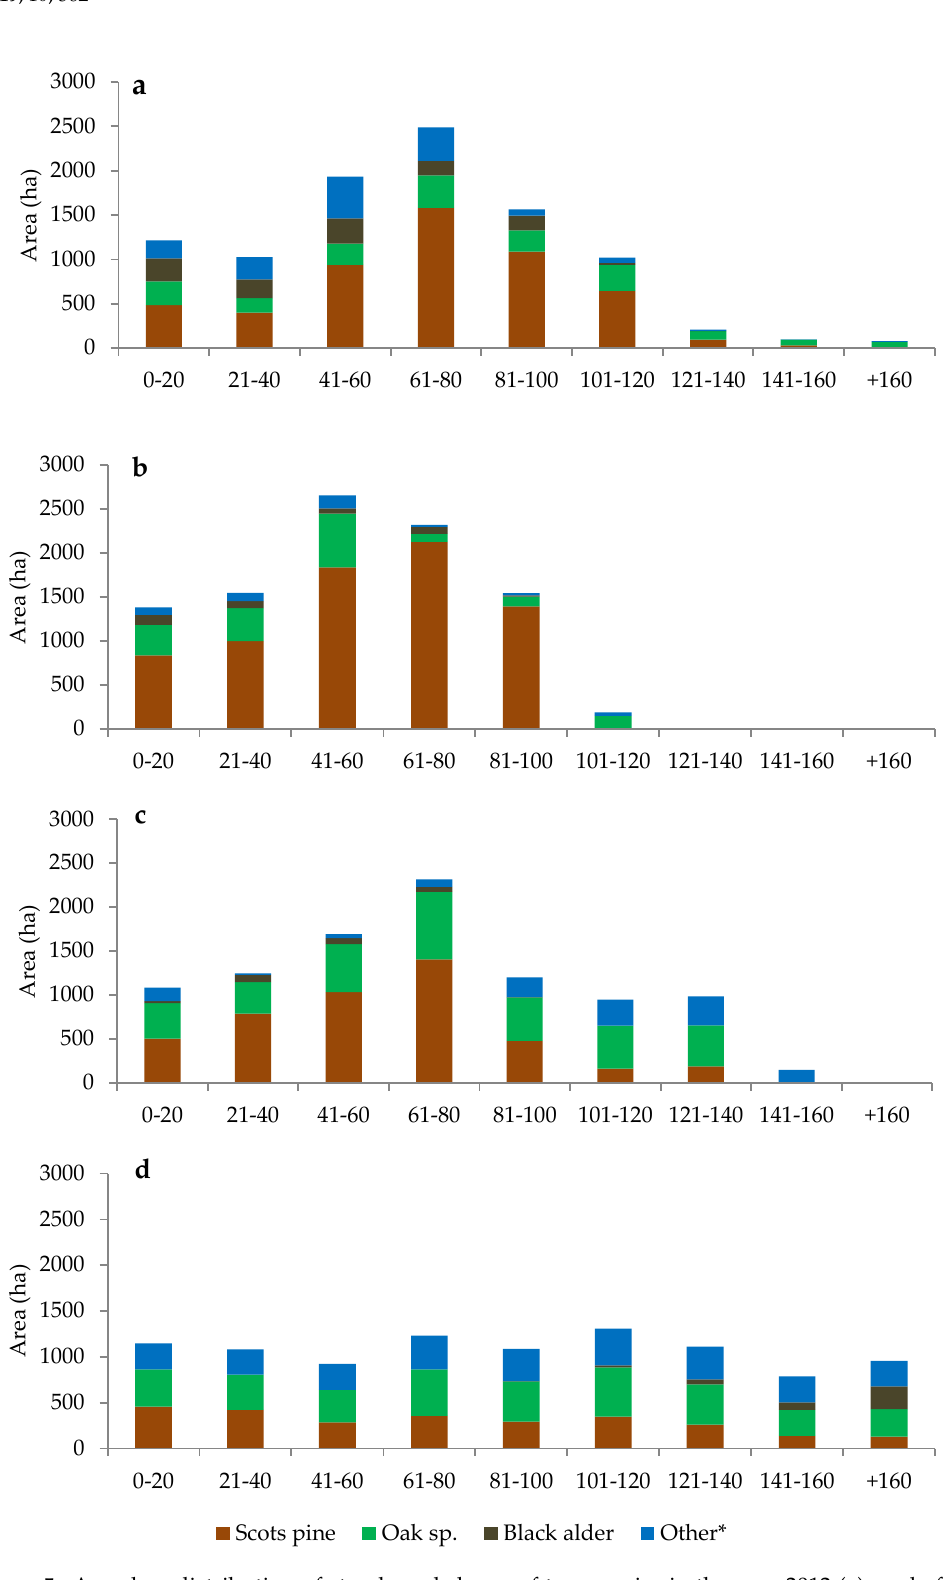
Figure 5. Age class distribution of stands and shares of tree species in the year 2012 ( a ), and after a 180-year simulation period for the productive, basic, and long rotation scenarios ( b , c , and d , respectively). * Other—silver birch, European beech, Norway spruce, European larch, hornbeam, European ash, small-leaved lime, common elm.